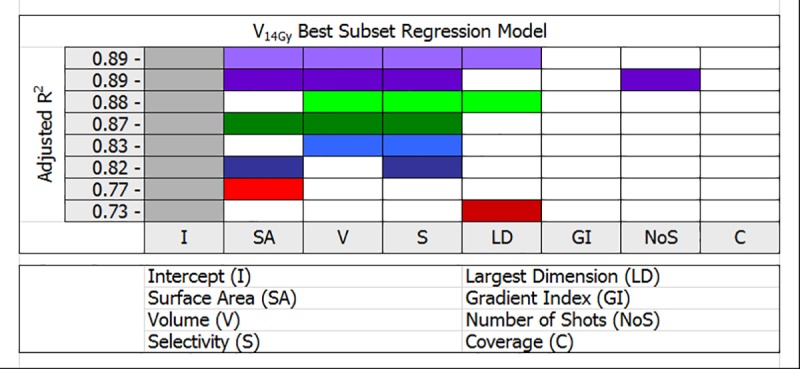
R multivariable V14Gy best subset linear regression analysis for 100 Gamma Knife meningioma patients.The color-coded parts in each row indicate number of variables used to model V14Gy volume. Best two models for a given number of variables are shown.